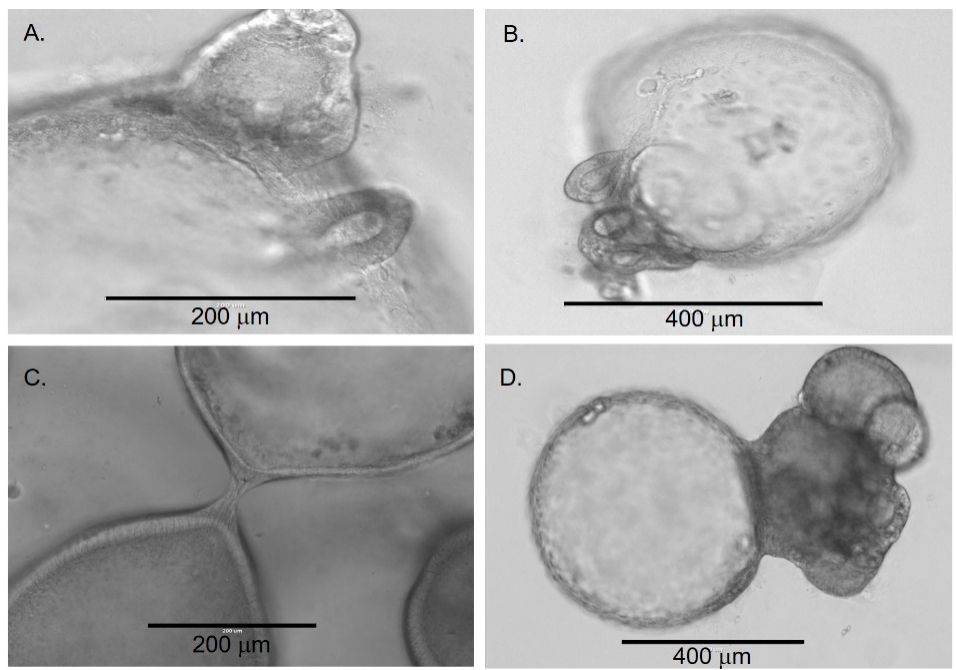
Figure 3. Transition of early chol-orgs into more complex forms. Budding ( A , B ) and merging ( C , D ) processes are observed as the chol-orgs transform into complex structures.